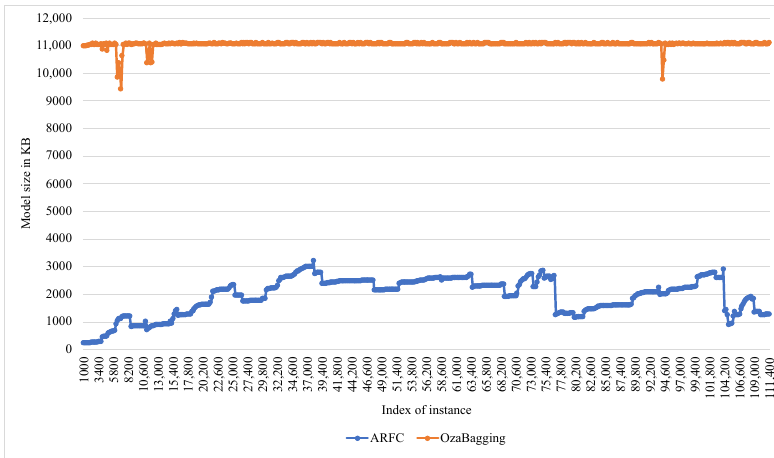
Figure 9. Comparison of Model size in Memory of ARFC and OzaBagging in Master